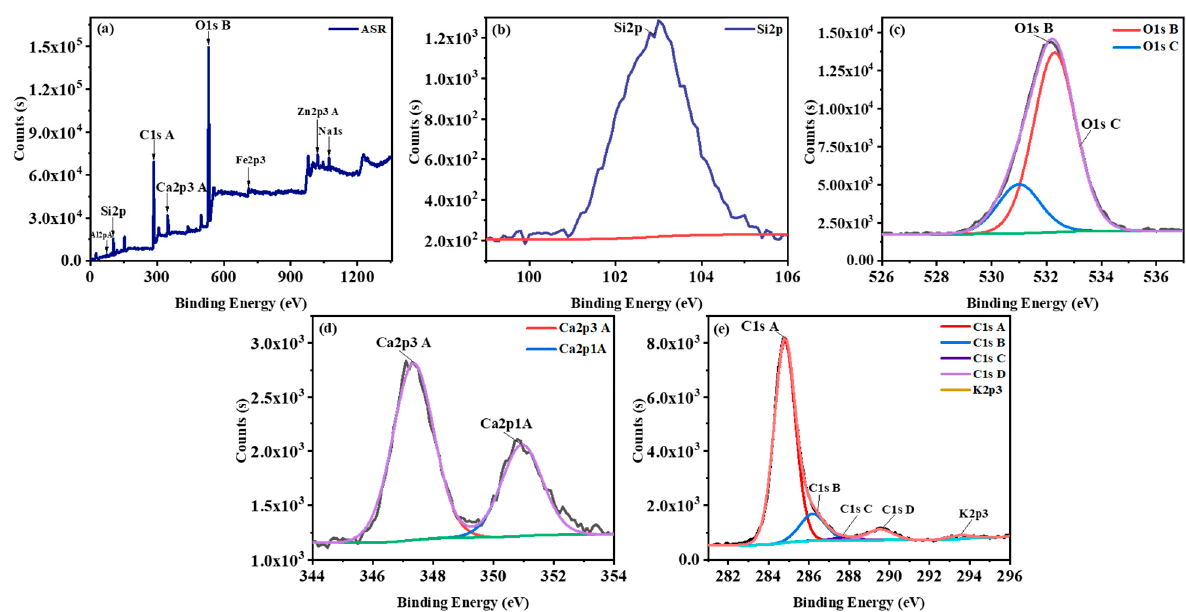
Figure 3. ( a ) XPS survey scan of the mixed plastics of ASR and typical high-resolution XPS spectra of ( b ) Si2p, ( c ) O1s, ( d ) Ca2p, ( e ) C1s.